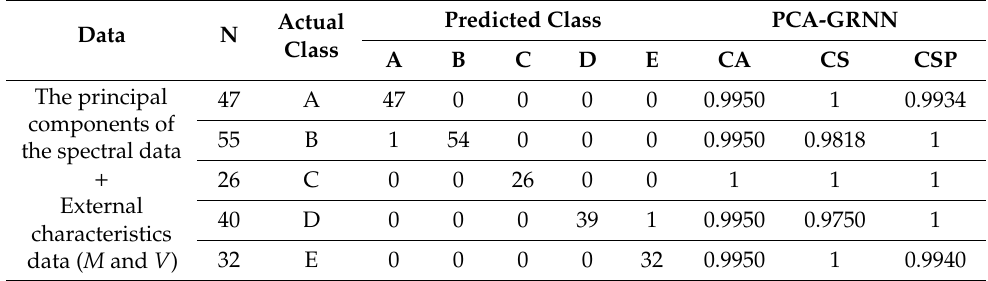
Table 7. The influence of multi-source data fusion on the predictive performance of